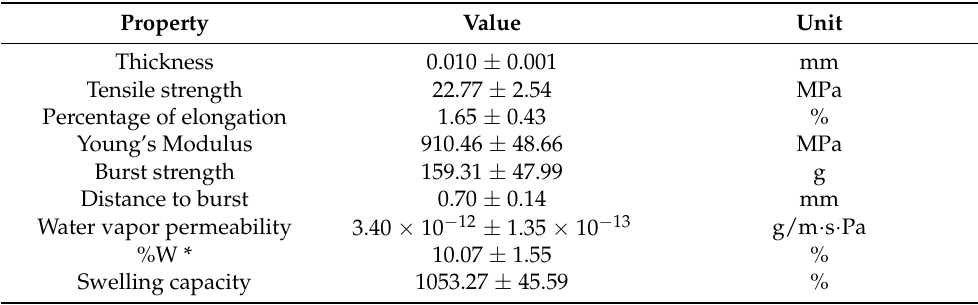
Table 3. Physicochemical properties of bacterial cellulose films synthesized in bagasse–potato culture